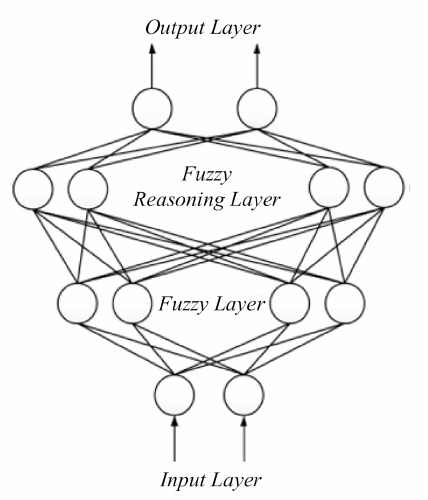
Figure 4. Fuzzy radial basis function neural network structure